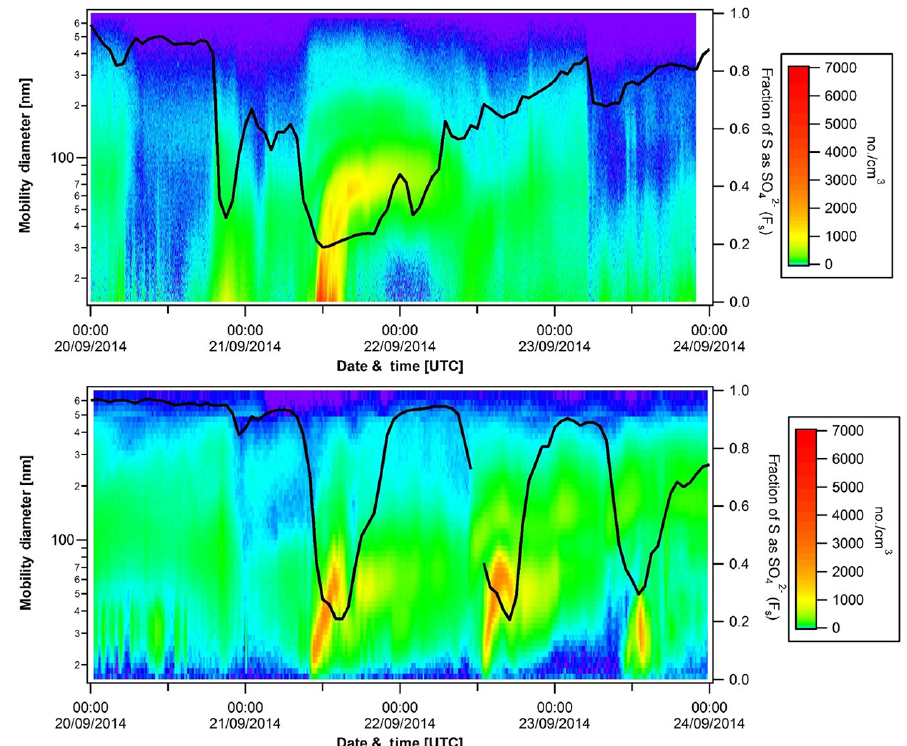
Figure 5. Particle number concentration at Auchencorth Moss (top panel) and Harwell (bottom panel) (refer to Fig. 1 for map) during the September 2014 volcanic plume event. Right-hand y axis is the F s ratio (black line) measured by the MARGA for the same period, where lower F s indicates “younger” SO 2 − . (Note: there are uncertainties regarding the size calibration of the instrument (see text), but the CPC 4 was working correctly. The panel should therefore be regarded a qualitative indicator of an increase in the ultrafine particulate matter during the volcanic